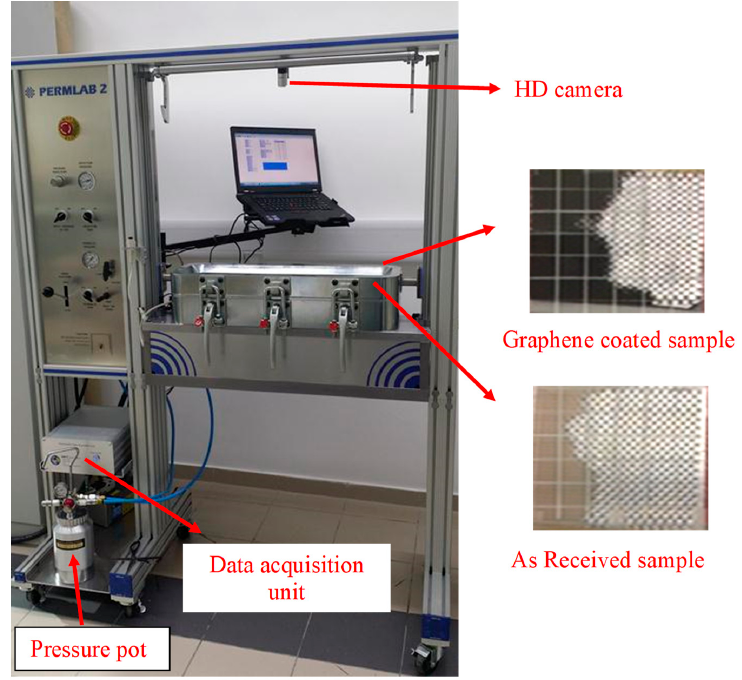
Figure 4. In-plane permeability experimental setup.